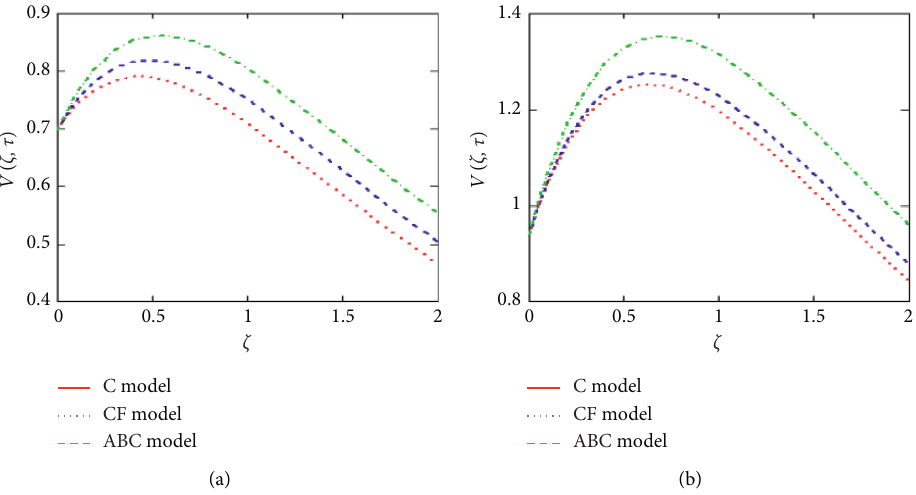
Figure 2: Comparison of the velocity profile for C, CF, and ABC with the variation of time.